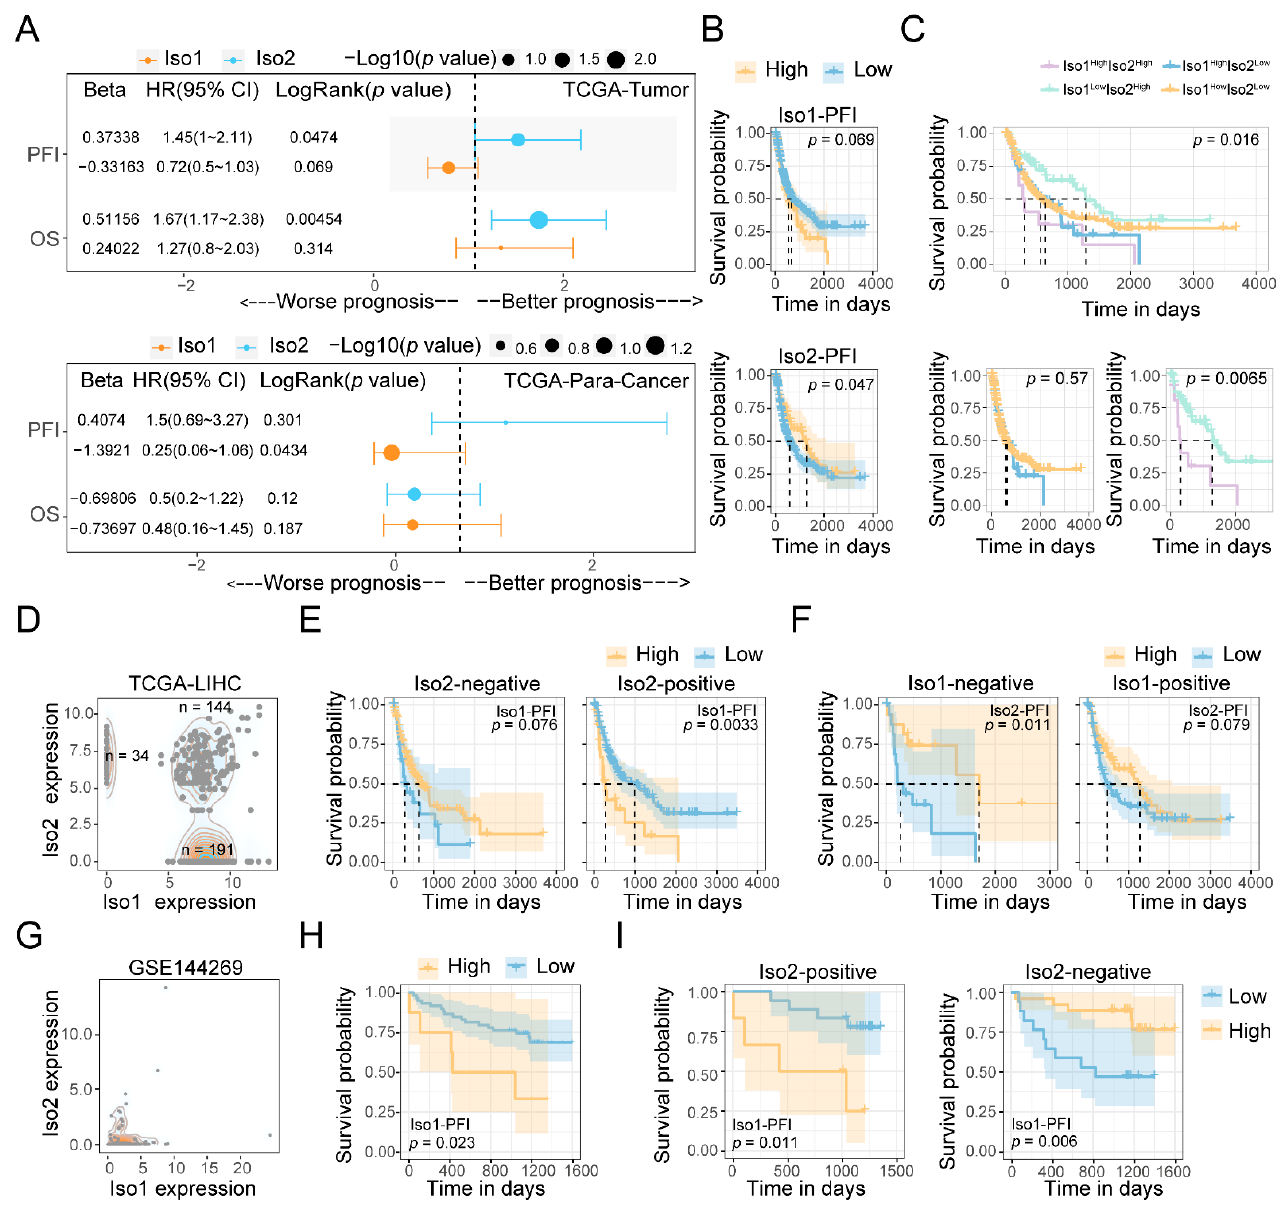
Figure 2. The prognostic e ff ects of Iso2 and Iso1 and their interplays in LIHC. ( A ) Uni-Cox analysis of Iso1 and Iso2 levels on di ff erent survival indicators in both tumor and para-cancer tissues. ( B , C ) Kaplan–Meier analysis of the e ff ects of Iso1 and Iso2 on PFI. The optimized cut-o ff points for Iso1 or Iso2 levels were calculated by Survival package. ( D ) Density plot showing the expressional distribution of Iso1 and Iso2 in TCGA-LIHC patients. ( E , F ) Kaplan–Meier analysis using zero as the cut-off points. ( G ) The expressional distribution of Iso1 and Iso2 in the Mongolian liver cancer cohort (GSE144269). ( H , I ) The roles of Iso2-positive expression in the prognostic effects of Iso1 were verified by the Mongolian data. Log-rank test was used for all Kaplan–Meier